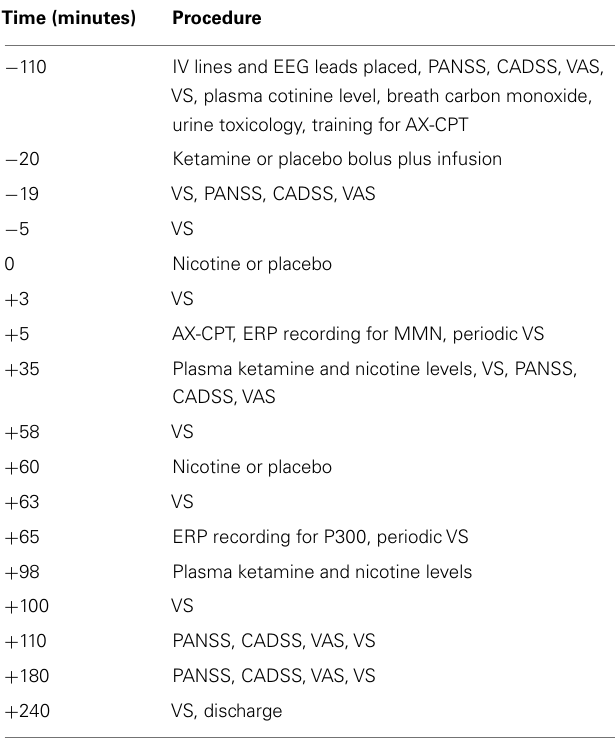
Table 2 | Study procedures